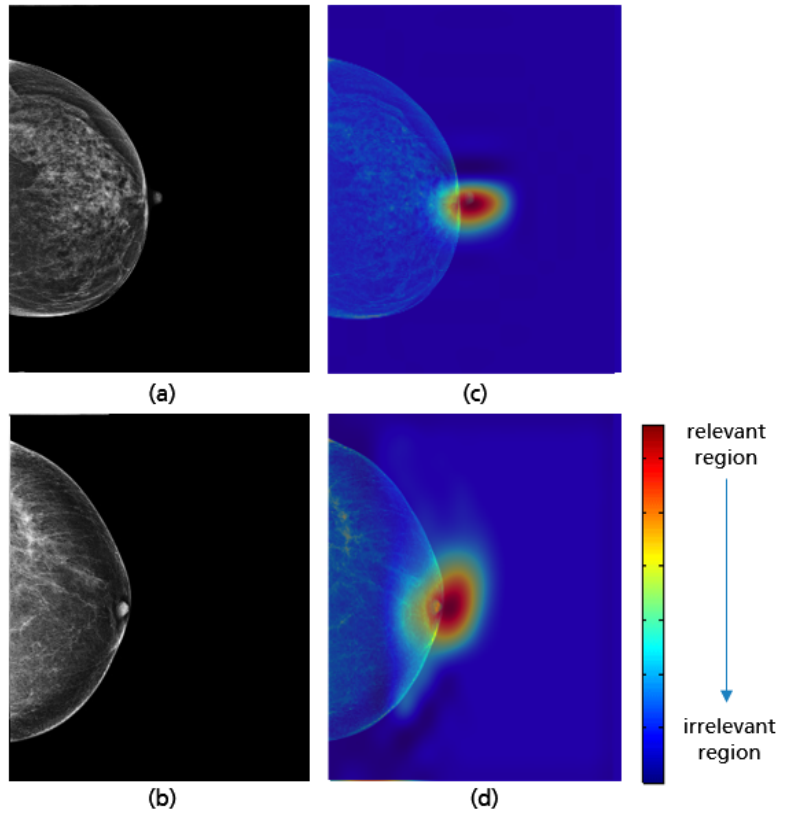
Figure 29. CC views with adequate ( a ), poor breast positioning quality ( b ) with regard to the nipple position and their Grad-CAM ( c , d ) highlighting the relevant region for the model